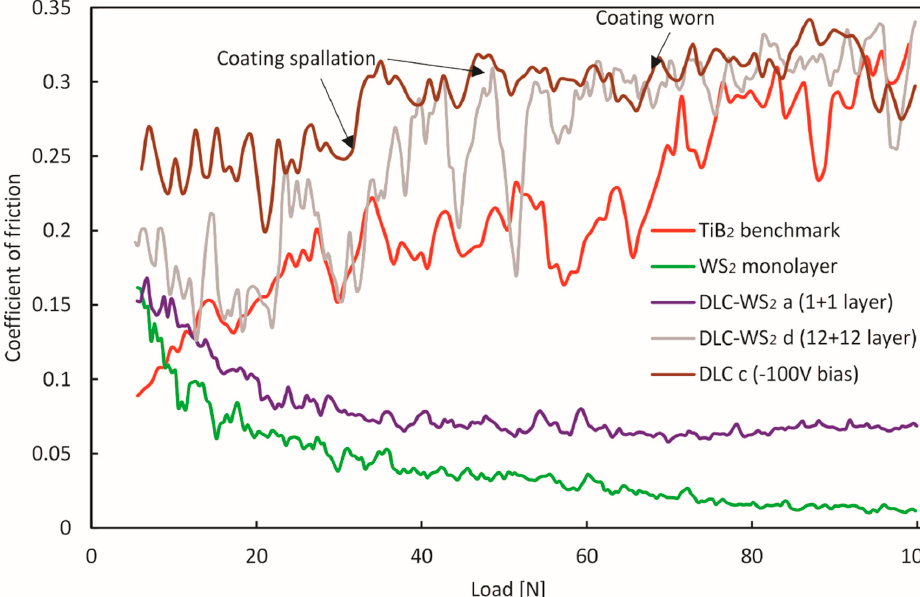
Figure 6. Friction coefficient vs load applied for DLC monolayer, DLC-WS 2 multilayers, and reference Table 2. and WS 2 -coated samples. Tests conducted by scratch test using fixed WC ball with 5 mm diameter ball sliding against a coated sample. Progressive load 5 N–100 N applied with 50 N/mm loading